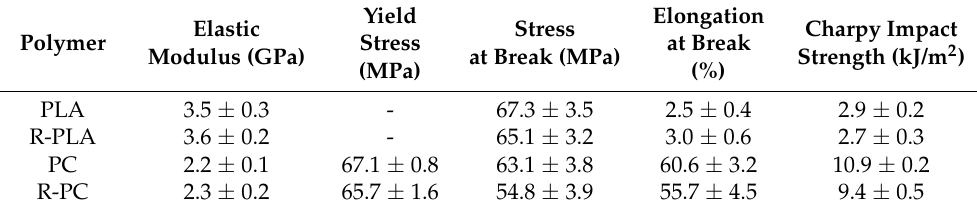
Table 2. Resumé of the mechanical properties for virgin and recycled polymers . Table 2. Resum é of the mechanical properties for virgin and recycled polymers. Polymer